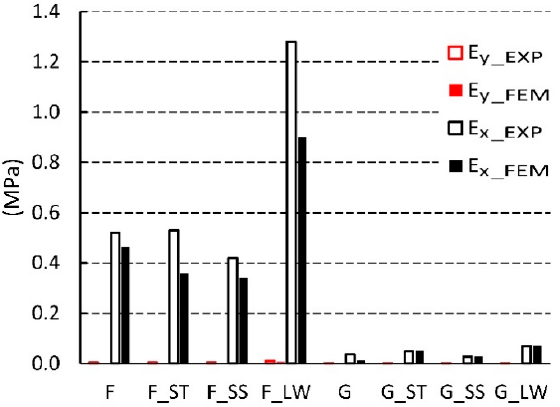
Figure 15. Linear modulus of elasticity for F, G cells (EXP-experimental research, FEM-numerical calculations).